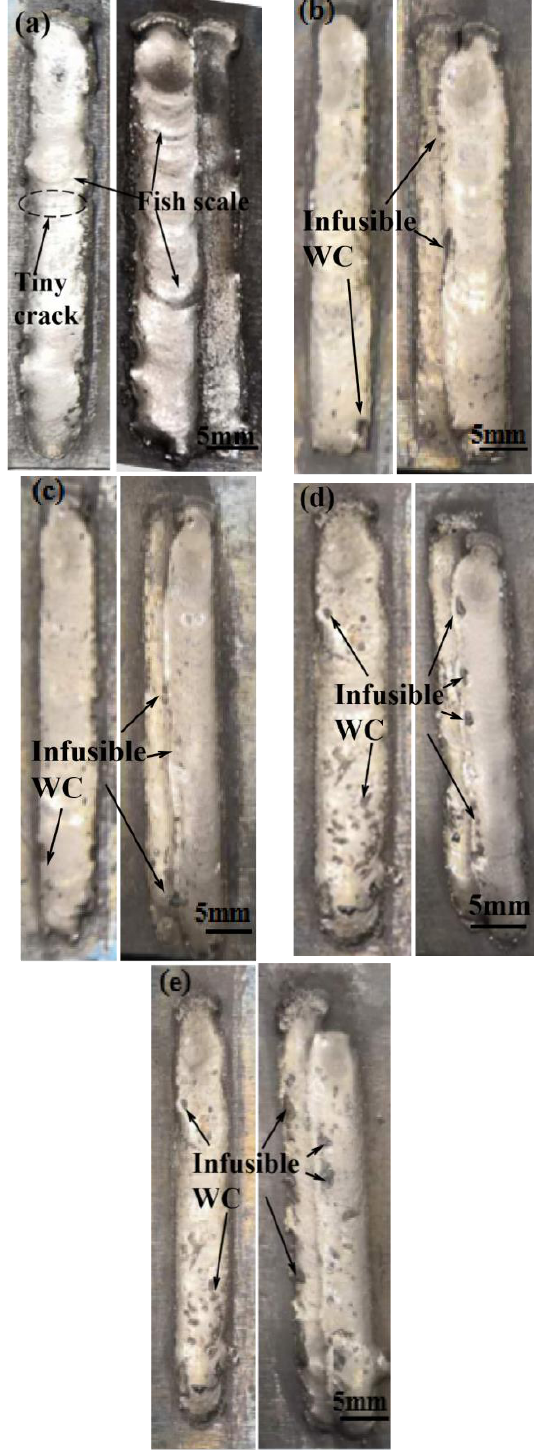
Figure 2. Surface morphology of the samples containing different amounts of CeO 2 : ( a ) 0%, ( b ) 0.5%, ( c ) 1.0%, ( d ) 1.5%, and ( e ) 2.0%.